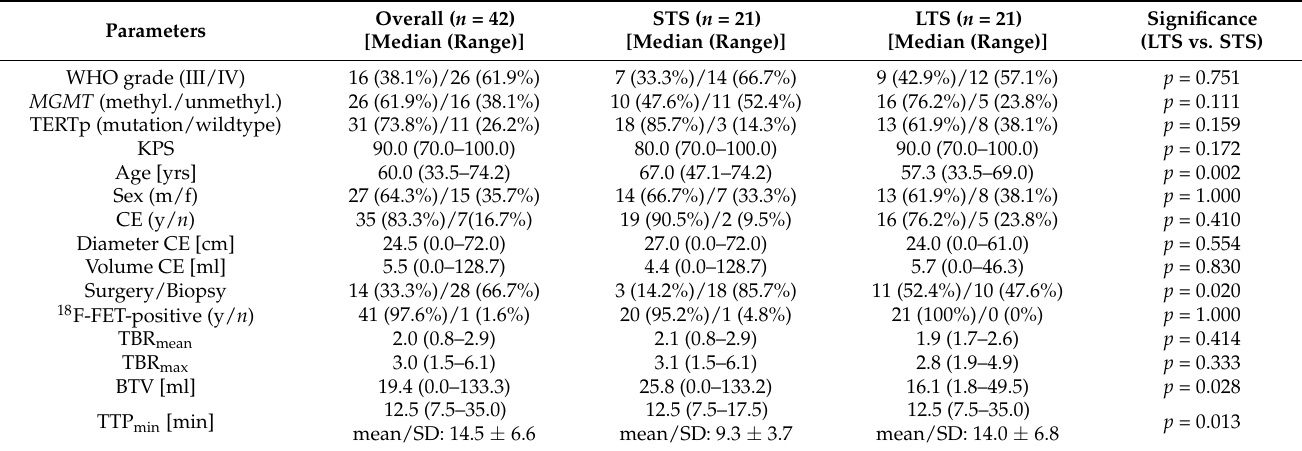
Table 3. Overview patients matched for WHO grade and molecular genetics and overview differences STS and LTS ( ≤ 15 vs. ≥ 36 months).